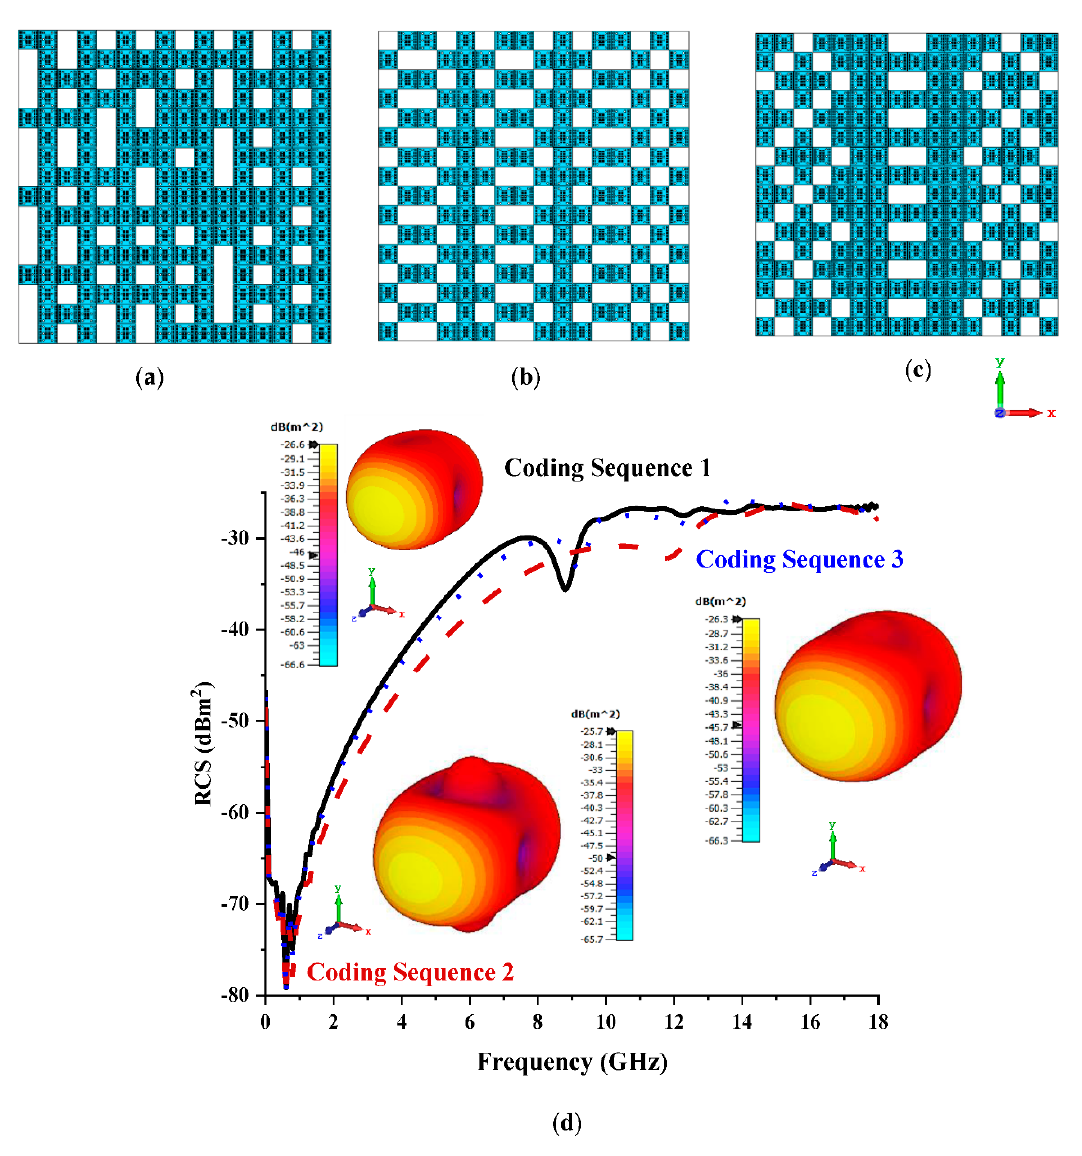
Figure 5. Sixteen lattices: ( a ) Coding Sequence 1; ( b ) Coding Sequence 2; ( c ) Coding Sequence 3; ( d ) monostatic RCS and bistatic scattering pattern at 15 GHz.